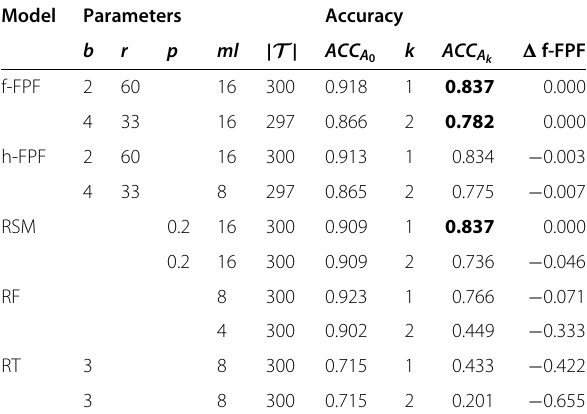
results for each k